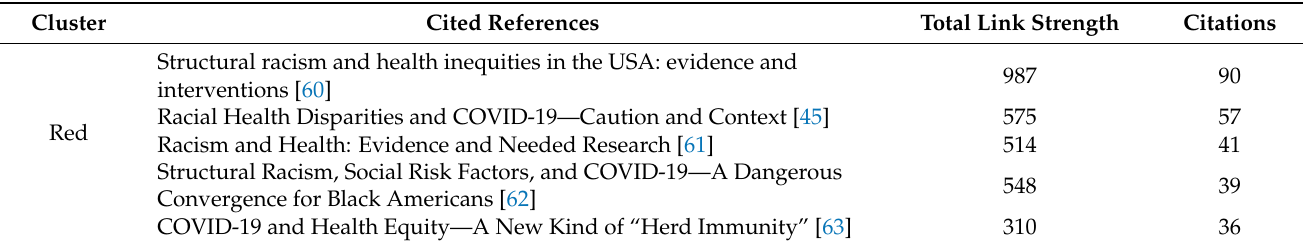
Table 8. The top 5 highly co-cited references in five largest